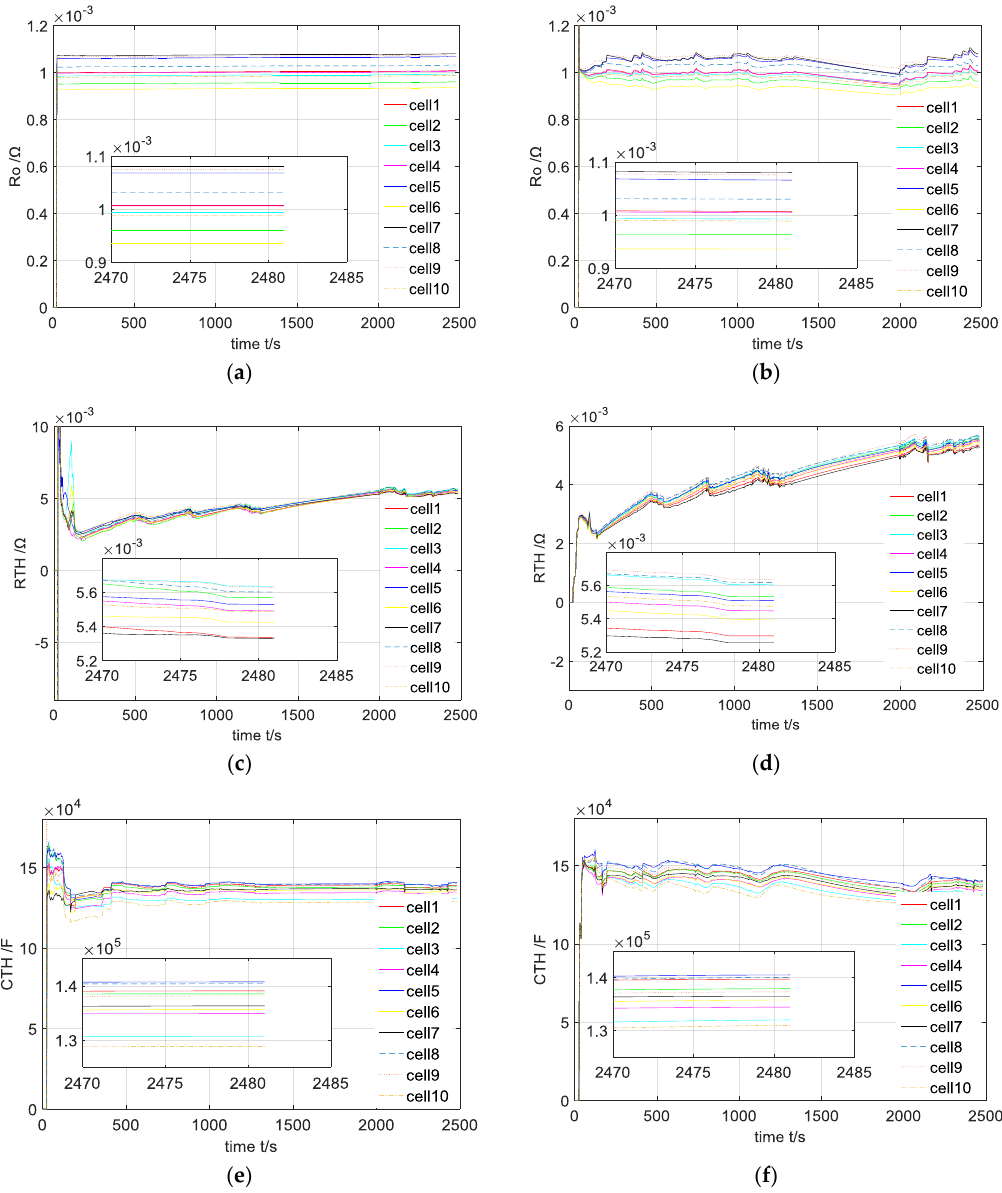
Figure 11. Identified parameters under the FTP-75 cycle test: ( a ) R O identified by the repetitive RLS; ( b ) R O identified by the proposed new method; ( c ) R TH identified by the repetitive RLS; ( d ) R TH identified by the proposed new method; ( e ) C TH identified by the repetitive RLS; and ( f ) C TH identified by the proposed new method.